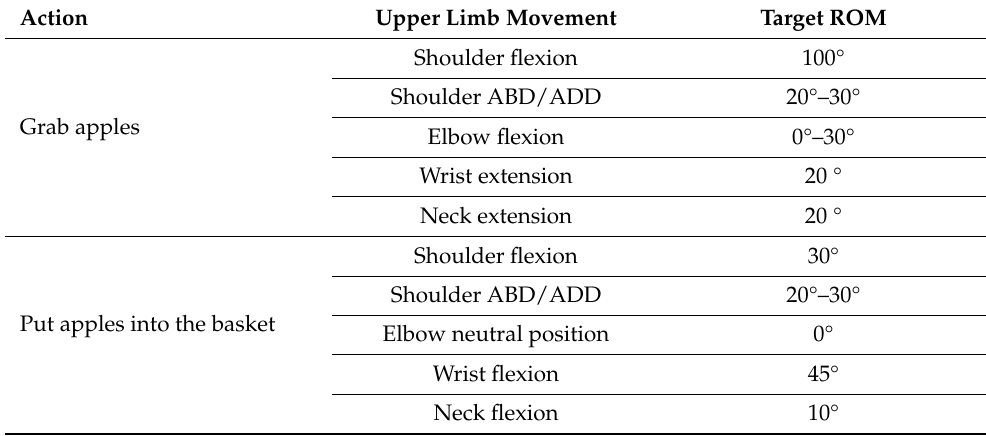
Table 5. Sequence of actions and the upper limb movements involved in the picking apples from trees